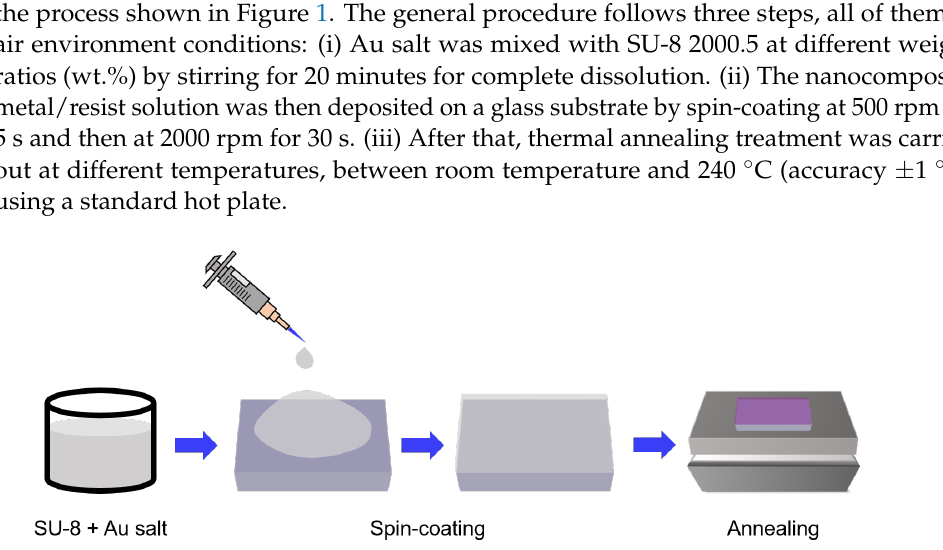
Figure 1. Fabrication procedure of Au NPs in polymer film by a solvent-evaporation-assisted thermal annealing